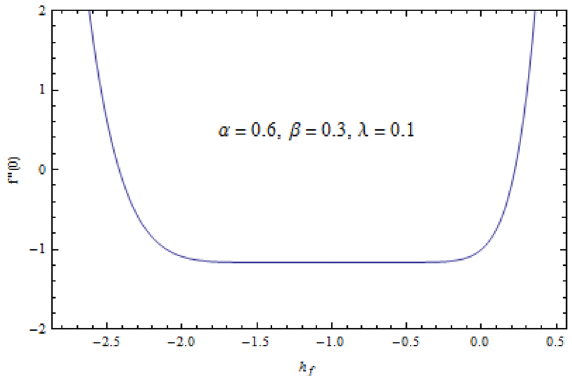
Fig. 1 (cid:2) f − curve for velocity